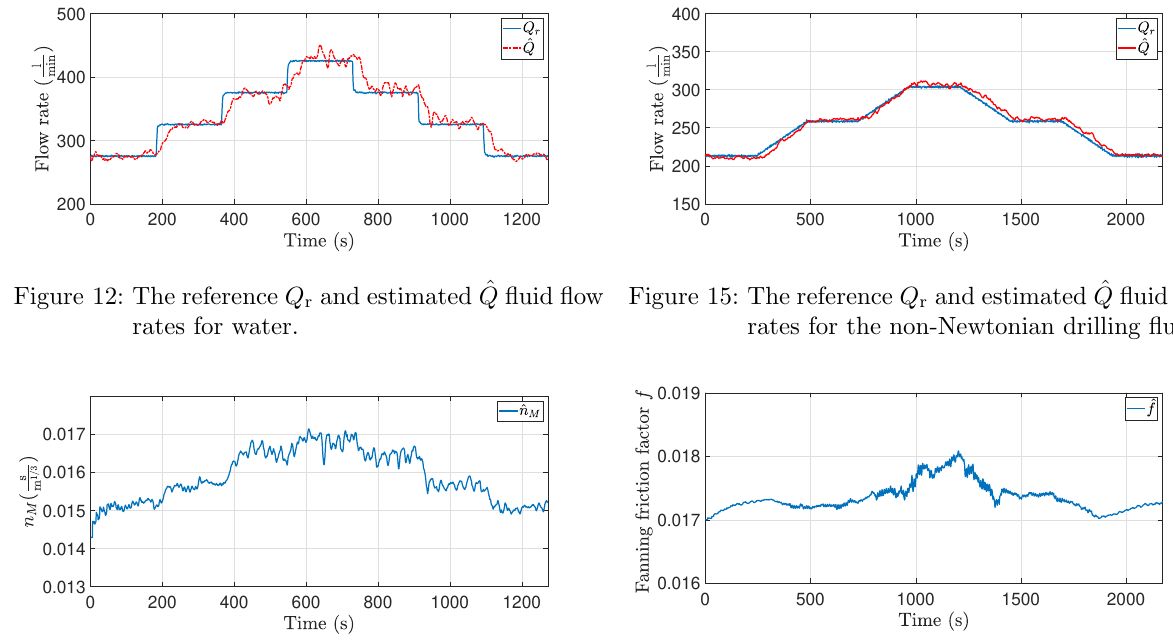
Figure 13: The estimated Manning’s friction factor ˆ n M for water.